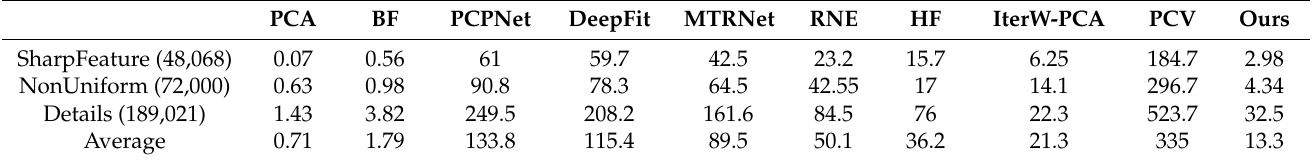
Table 1. Mean computational time (in seconds) of different algorithms.